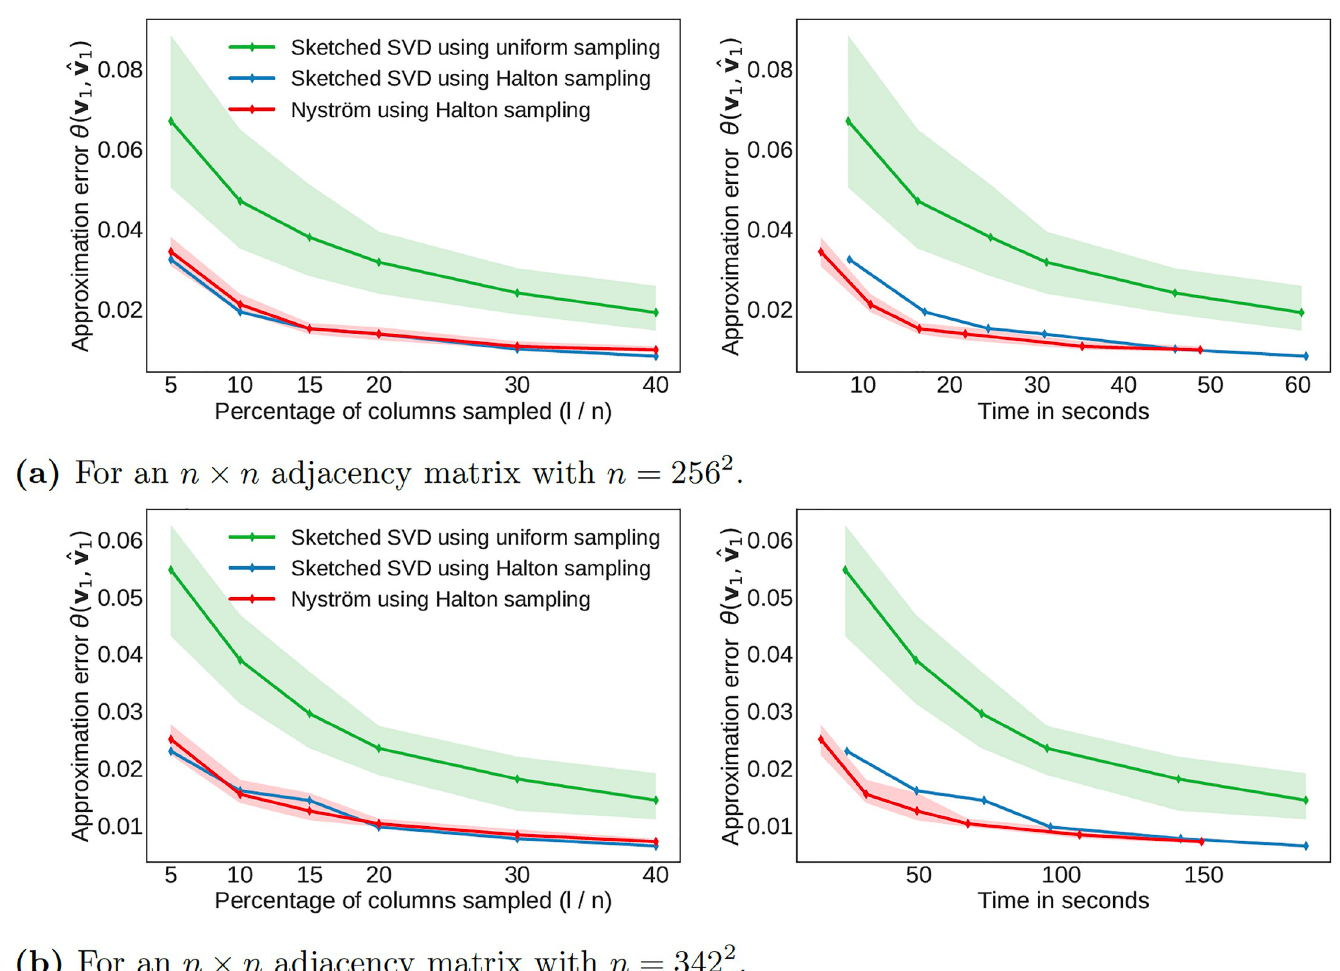
Fig 5. Computational performance for the isotropic turbulent flow using two different spatial resolutions. The results are averaged over 20 runs using different random seeds. The shaded region indicates the variance of approximation error in multiple runs.